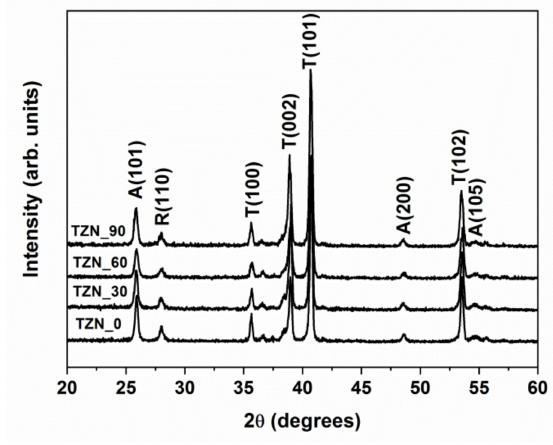
Figure 3. X-ray di ff raction patterns of the investigated